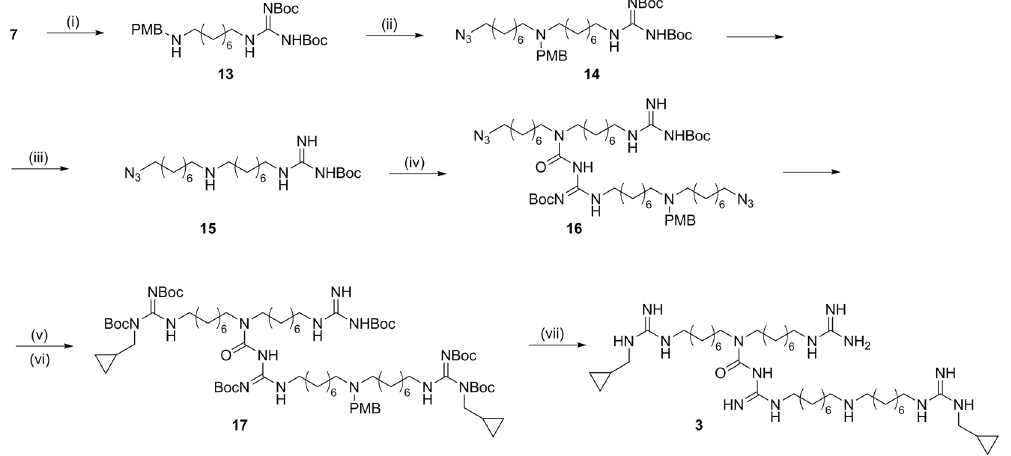
Figure 7. Synthesis of asymmetric dimer ( 3 ). Reagents and conditions: (i) 1) p -Anisaldehyde, CH 3 OH, r.t., 3 h; 2)